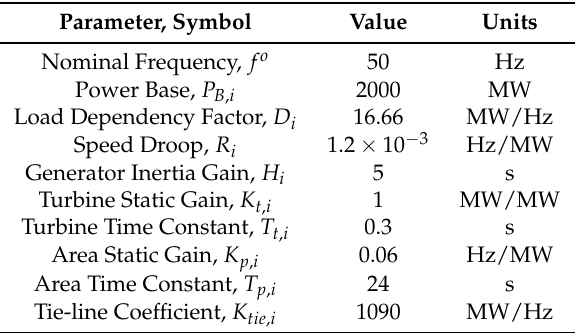
Table 1. Parameters and power system